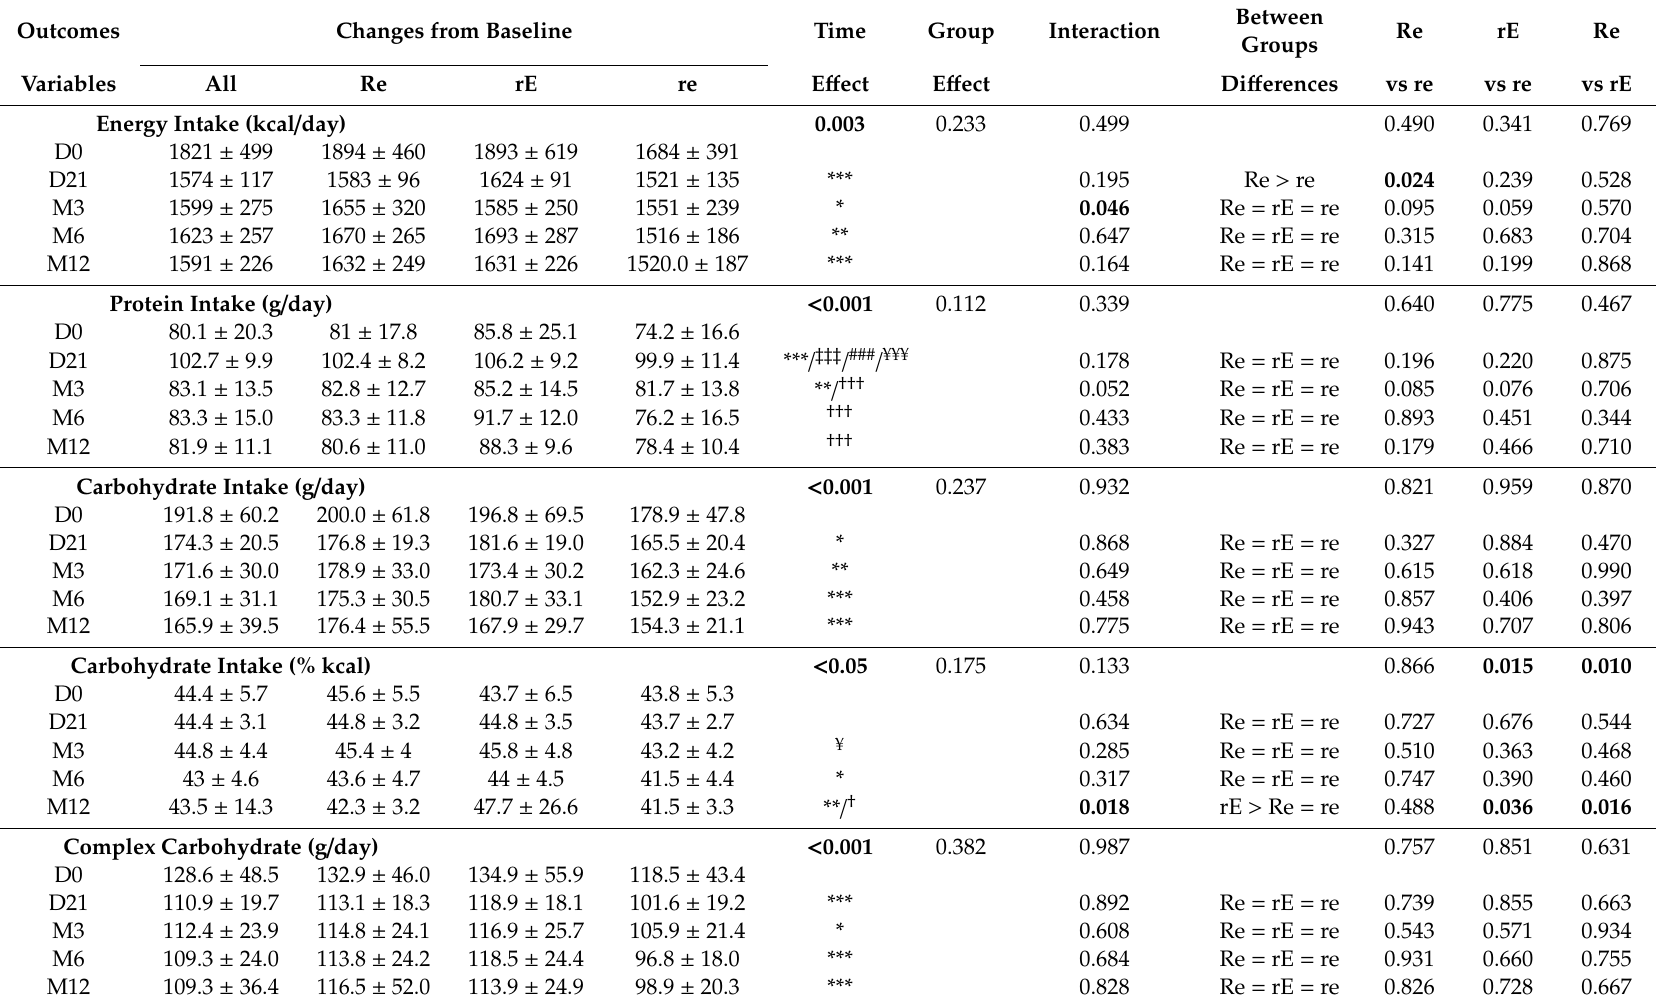
Table 1. Energy and nutrient intake during the